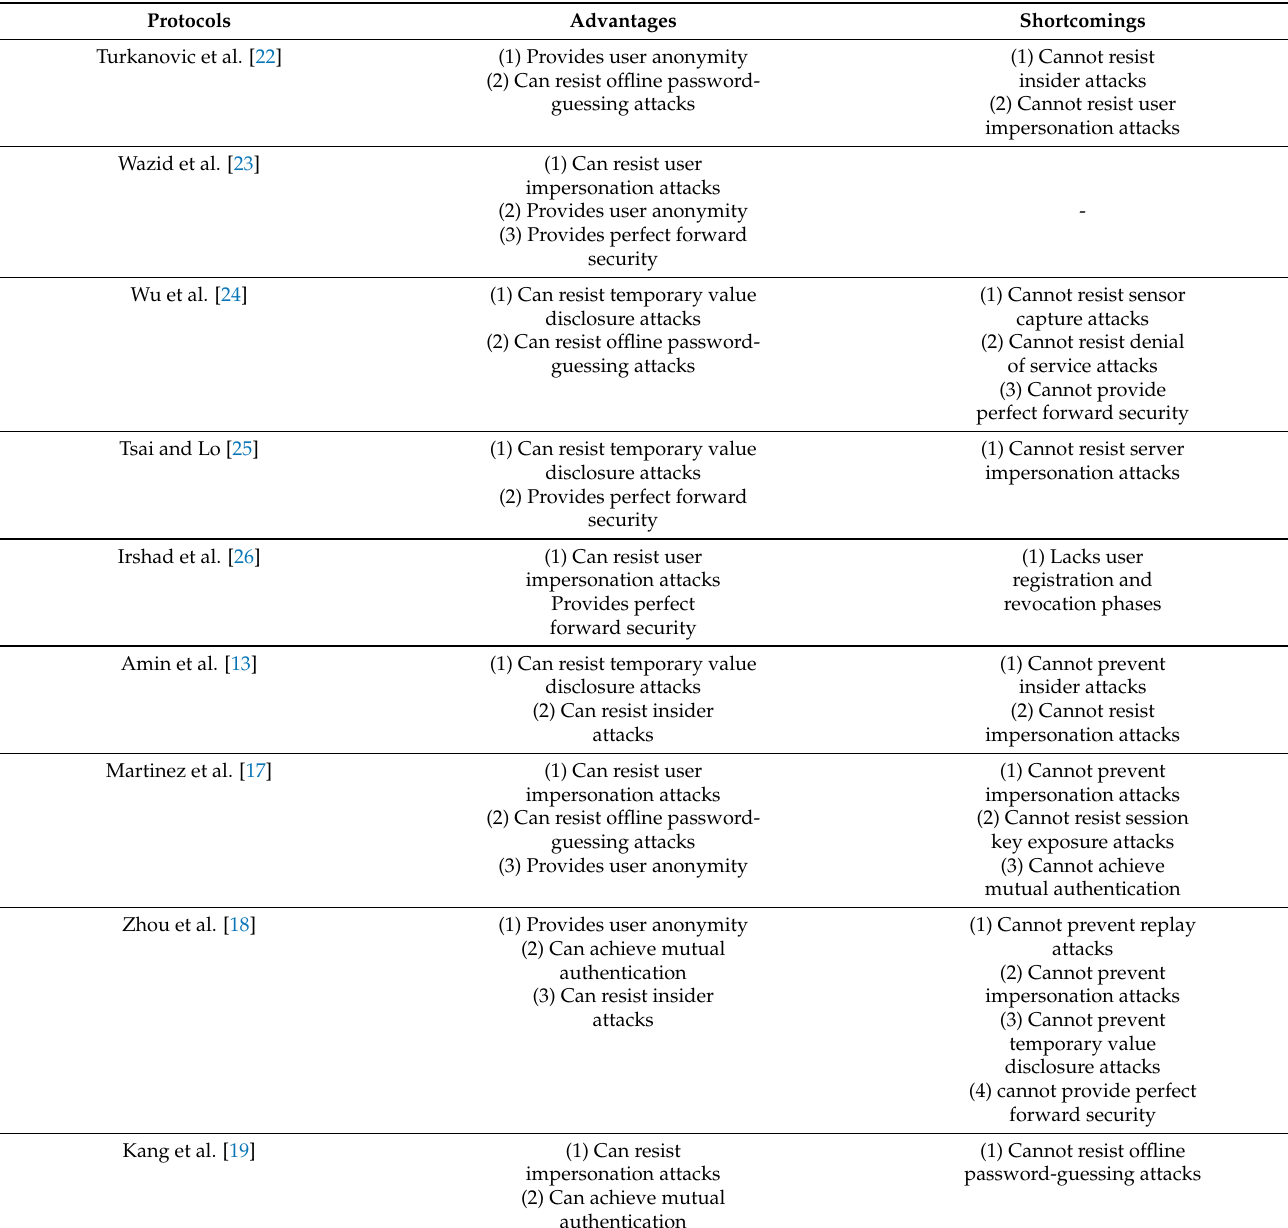
Table 1. A summary of authentication